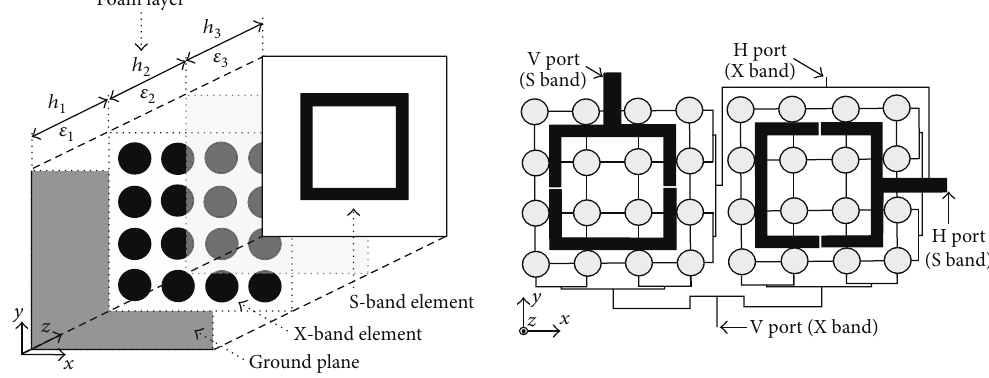
Figure 26: A dual-polarized planar-array antenna for S and X band [63].